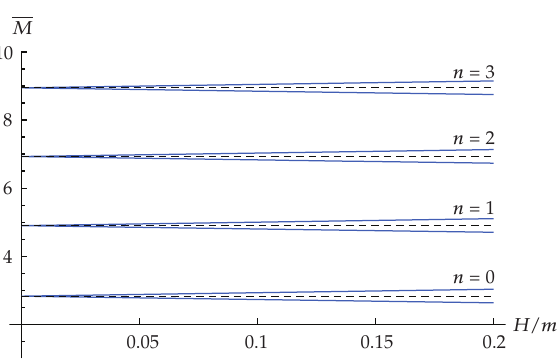
Figure 4: Plot of M (cid:8) MR 2 /m versus H/m for the first three states. The dashed black lines correspond to the spectrum given by (cid:3) 4.50 (cid:4)